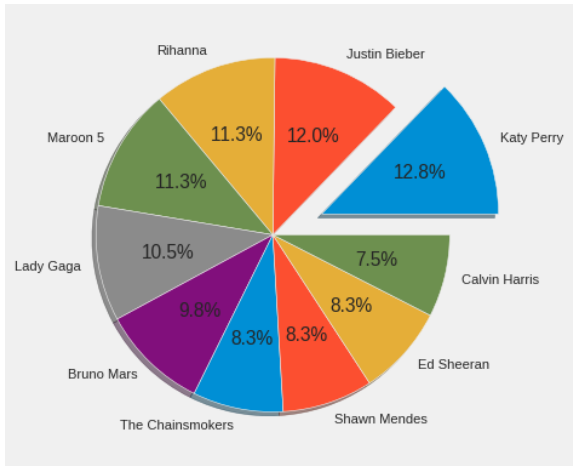
Figure 5. Pie chart representing the top 10 (2009-2019)